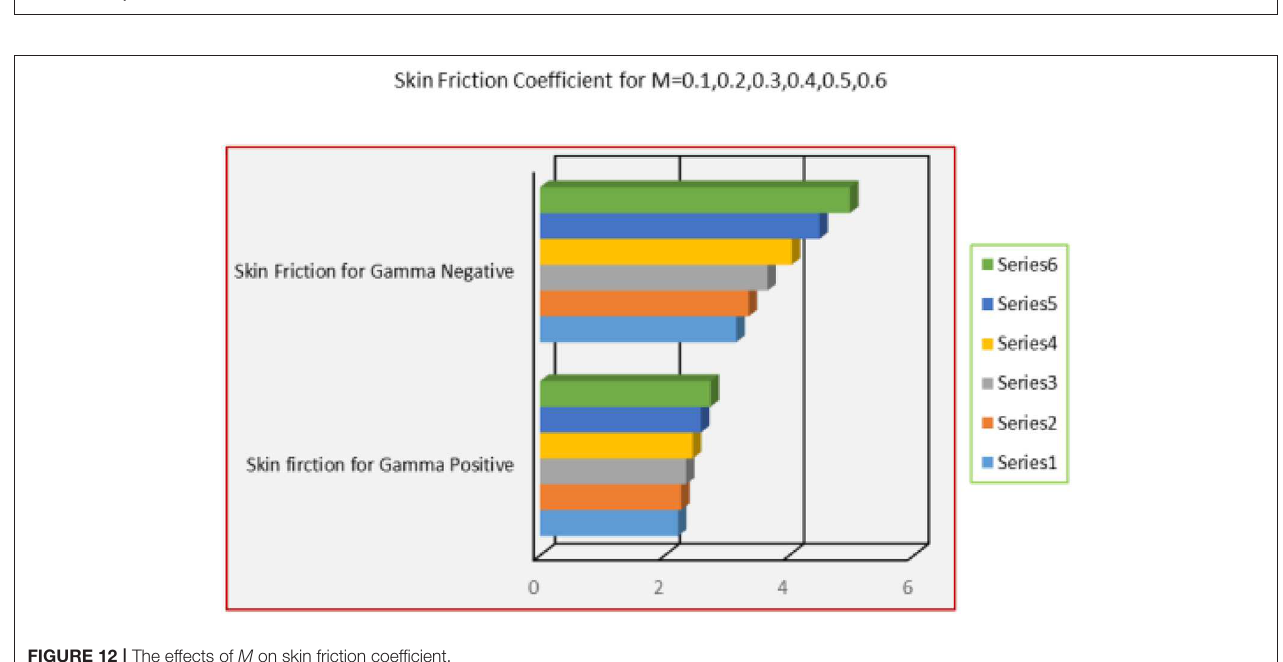
FIGURE 12 | The effects of M on skin friction